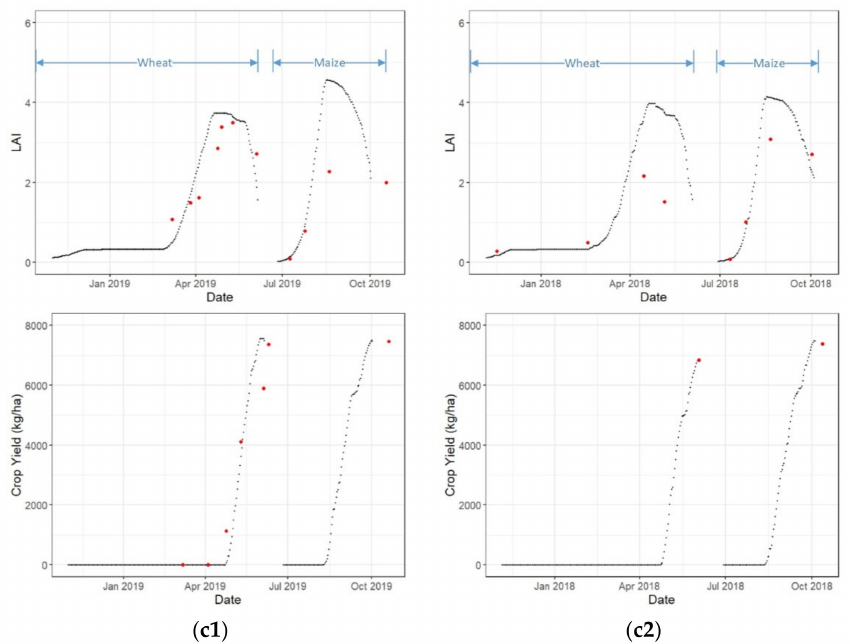
Figure 4. The model calibration and validation. ( a1 , a2 ): soil water content; ( b1 , b2 ): soil residual nitrate content; ( c1 , c2 ): leaf area index and crop yield; 1: model calibration; 2: model validation; red dots: field observed data; lines: simulated values.